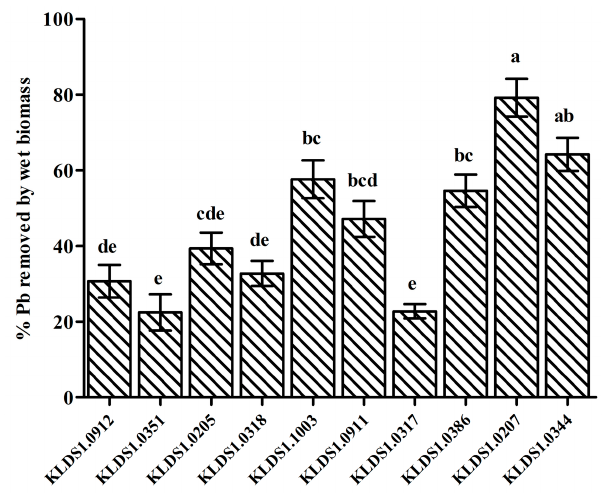
Figure 1. The Pb-binding ability of the tested lactic acid bacteria (LAB) strains when incubated with an initial Pb concentration of 50 mg/L. Values are mean ± SD of three determinations. Significant differences ( p < 0.05) among the strains are indicated with different letters above the graphical bars. KLDS1.0205, KLDS1.0911 and KLDS1.0912 are L. rhamnosus . KLDS1.0207 and KLDS1.9201 are L. bulgaricus . KLDS1.0386 and KLDS1.0344 are L. plantarum . KLDS1.1003 is L. acidophilus . KLDS1.0903 is L. helveticus . KLDS1.0351 is L. casei